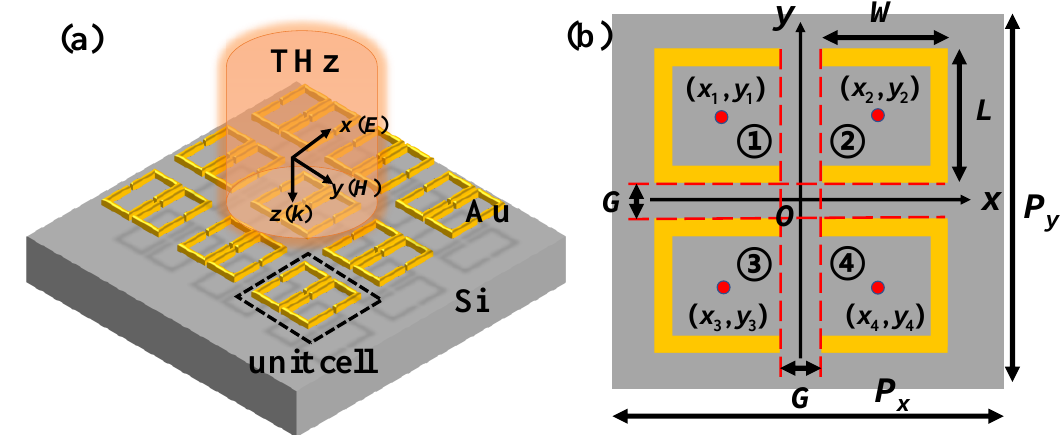
Figure 1. ( a ) Schematic drawing of the proposed reconfigurable terahertz (THz) metamaterial (RTM) device with four split-ring resonator (SRR) meta-atoms; ( b ) The geometric parameters of four SRR meta-atoms. The geometric dimensions are: W = 30 μm, L = 30 μm, G = 2 μm and P x = P y = 100 μm. The reference points are ( x 1 , y 1 ) = (−16, 16), ( x 2 , y 2 ) = (16, 16), ( x 3 , y 3 ) = (−16, −16) and ( x 4 , y 4 ) = (16, −16).